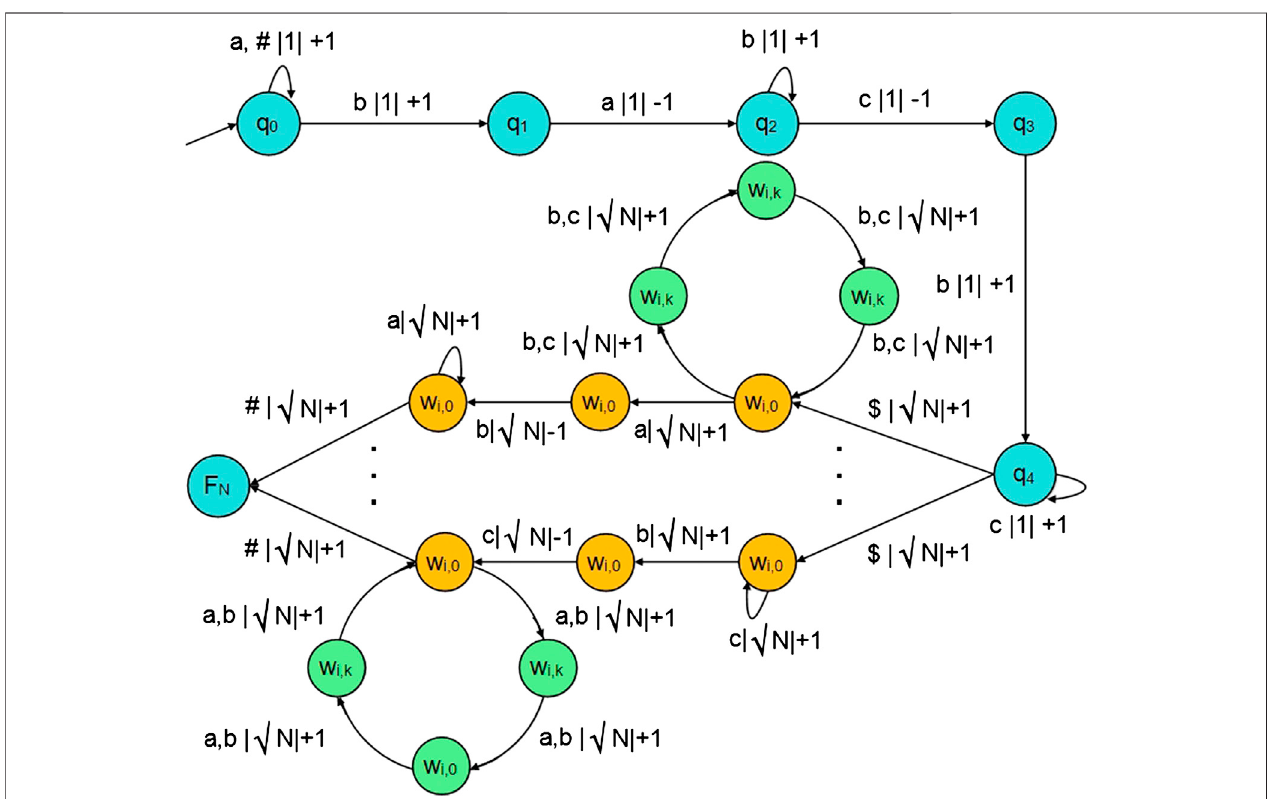
FIGURE 8 | State transition diagram of L 3 .